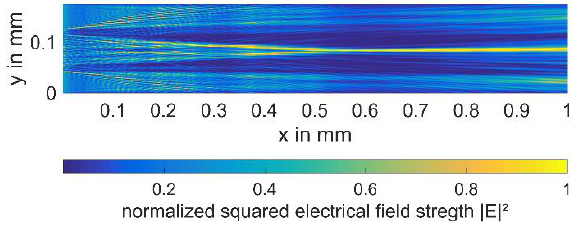
Fig. 5. Squared electrical field strength |E| 2 normalized to 1 depending on the propagation direction x, calculated from a profile section of a cylindrical lens fabricated in calcium fluoride (λ = 532 nm, n =